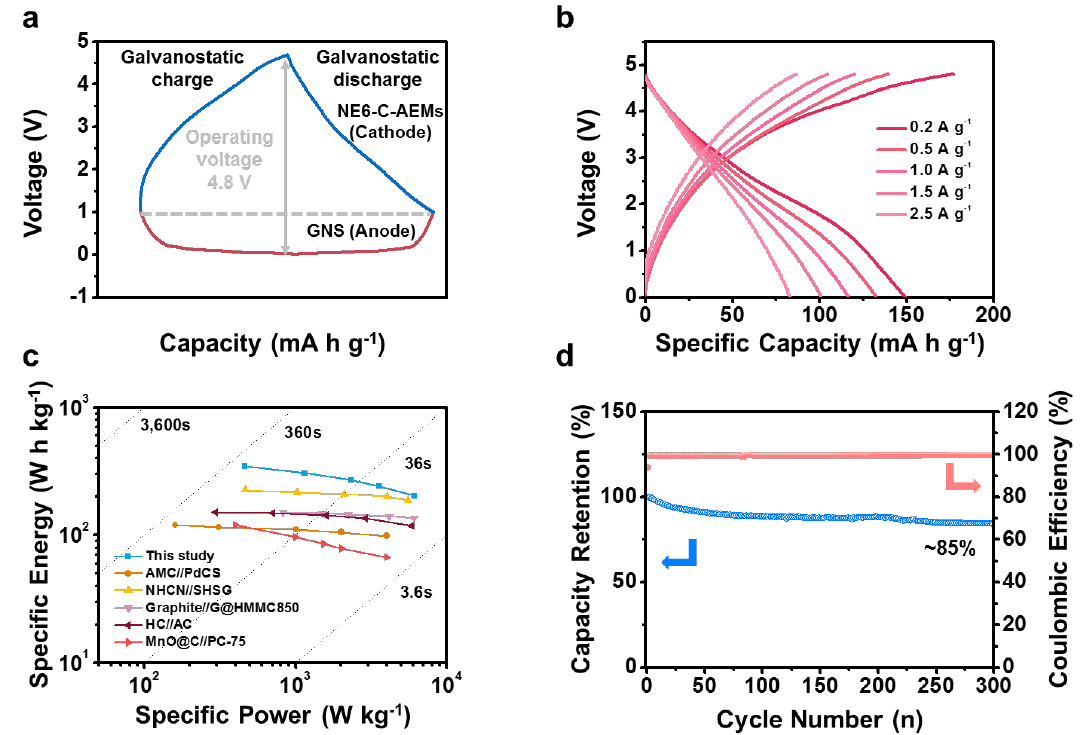
Figure 6. Electrochemical performance of GNS//NE6-C-AEM full cells in an electrolyte of 1 M LiPF 6 dissolved in EC/DMC mixture solution (1:1 v/v) over a voltage window between 0.01 and 4.8 V. ( a ) Schematic image of the respective galvanostatic voltage profiles of GNS anode and NE6-C-AEM cathode in the full cell system. ( b ) Galvanostatic charge/discharge profiles at different current densities. ( c ) Ragone plots of several energy storage devices, including GNS//NE6-C-AEM cells, and ( d ) capacity retention and coulombic efficiency results over 300 continuous cycles.